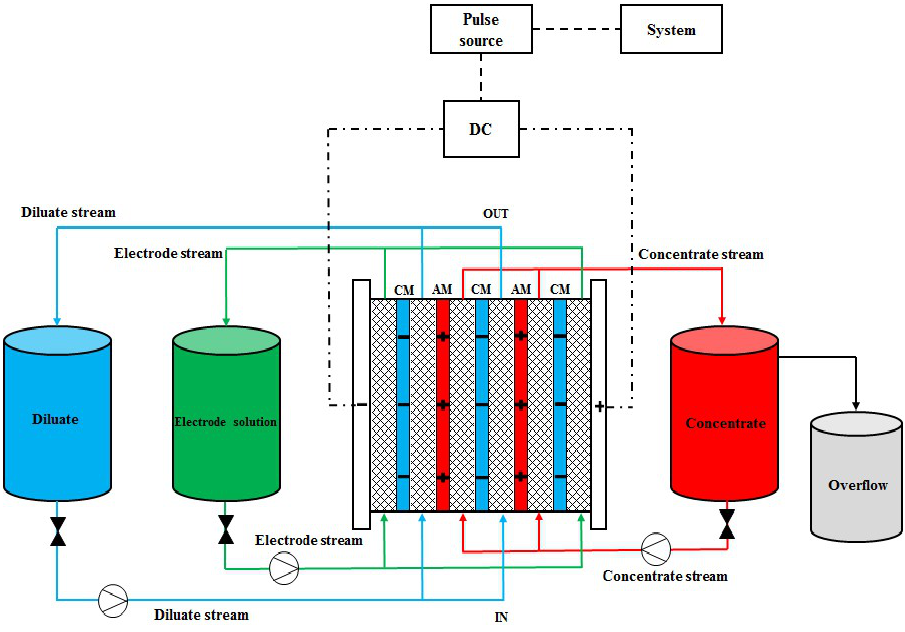
Figure 4. The configuration used for electrodialysis of